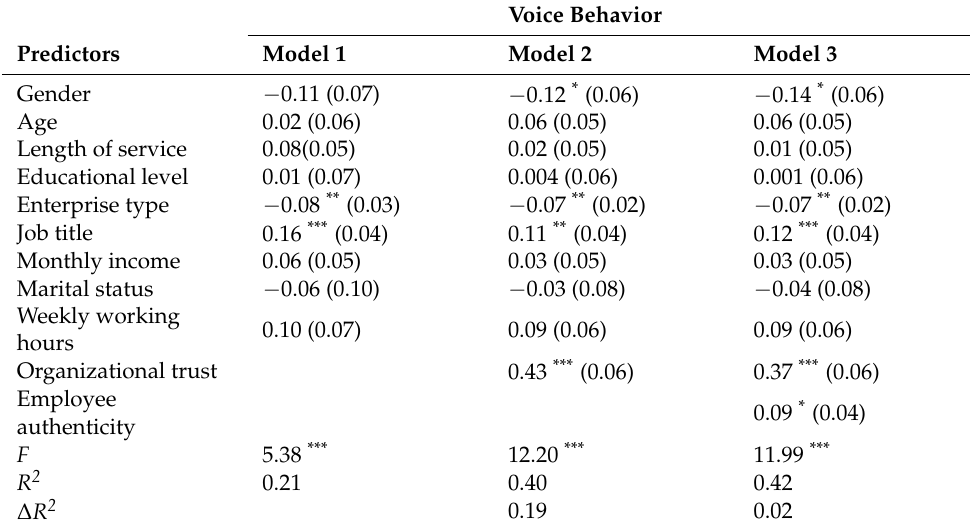
Table 2. Regression results of voice behavior in Study